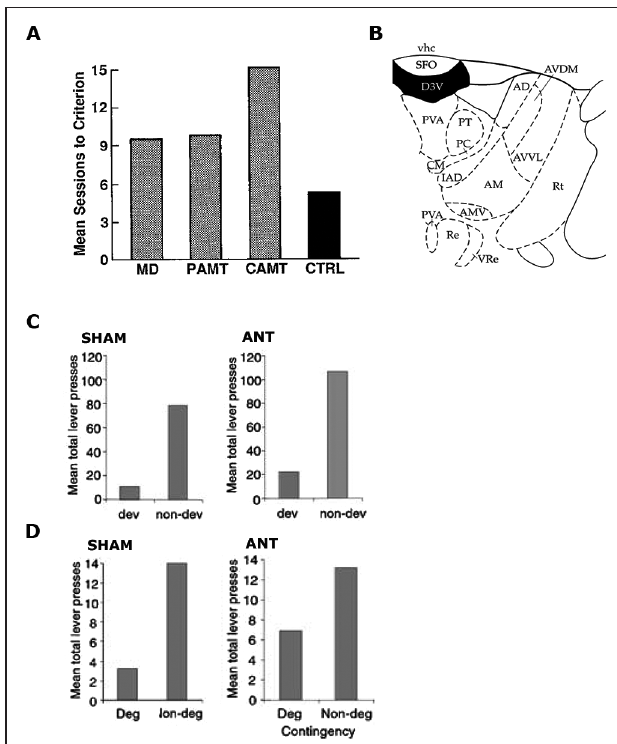
FIGURE 1 | (A) Reproduced from Gabriel et al. (1989). Mean sessions to criterion responding for rabbits with mediodorsal thalamus (MD), partial medial dorsal and anterior thalamic (PAMT), combined medial dorsal and anterior thalamic (CAMT) and control (CTRL) lesions. (B) Reproduced from Paxinos and Watson (1998). Schematic showing ANT at A/P: − 1.4 from Bregma. (C,D) Reproduced from Corbit et al. (2003), examines Sham and ANT-lesioned animals. (C) Mean total lever-press responses for the outcome devaluation test. (D) Mean total lever-press responses for the contingency degradation